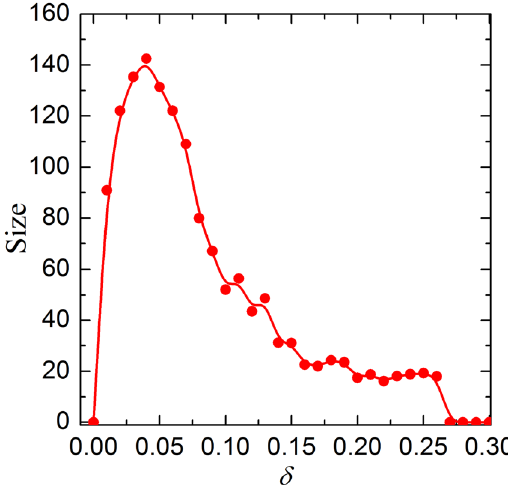
) for a 200 * 200 square lattice with ε = . 0 8 and c